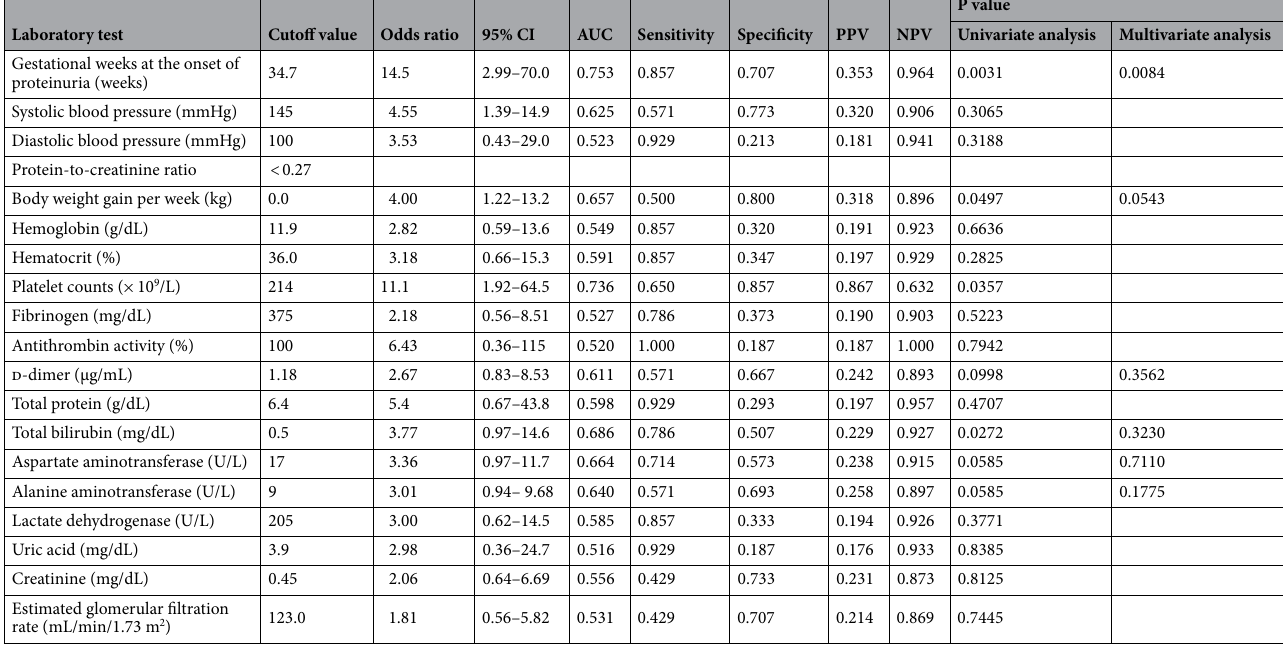
Table 3. Relationship between laboratory cutoff values and progress from presumptive gestational hypertension to preeclampsia. Laboratory findings were based on the receiver operating characteristic curve. CI confidence interval, AUC area under the curve, PPV positive predictive value, NPV negative predictive